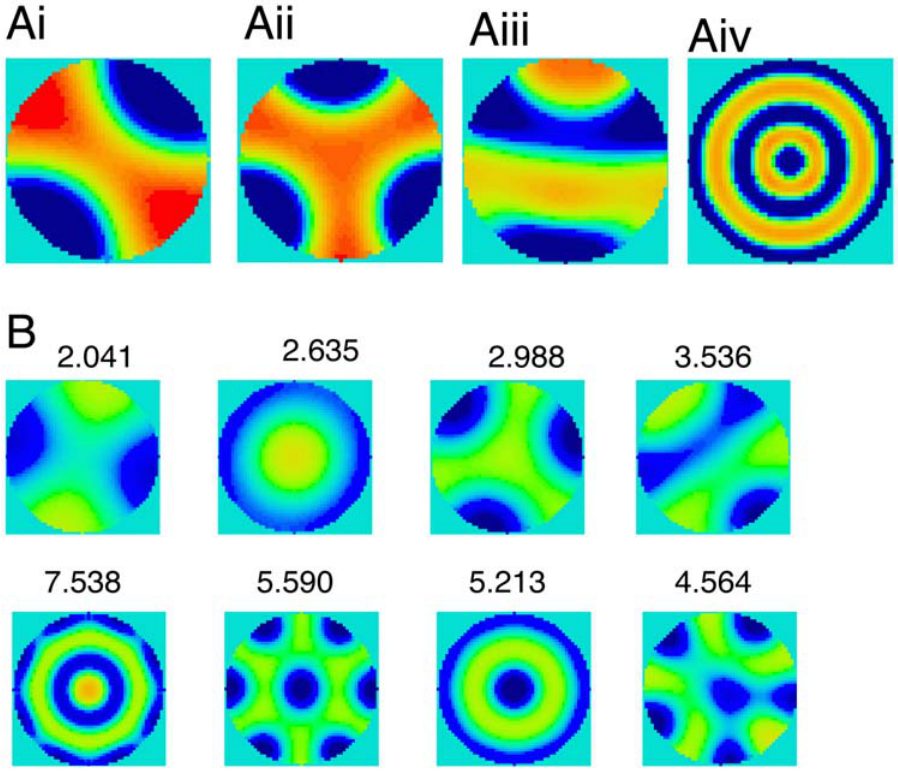
Figure 5. Numerical solutions to the full nonlinear equations. f ( n ) ~ 5 n 2 = (1 z n 2 ) and D n ~ x . A) Numerically computed representations of the 4 standard patterns. Ai) D n ~ 200, D c ~ 35 ; Aii) D n ~ 100, D c ~ 18 ; Aiii) D n ~ 60, D c ~ 14 ; A4) D n ~ 8, D c ~ 2 . B) Sequence of patterns with D c ~ 0 : 3 D n as D n decreases. Numbers next to patterns are 25 = ffiffiffiffiffiffi D n p